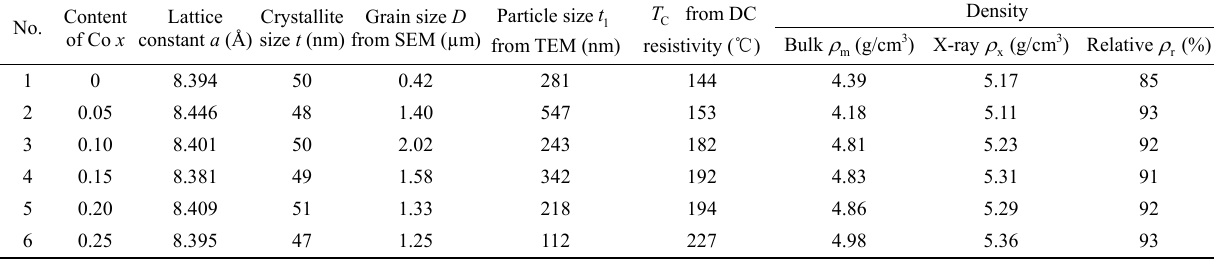
Table 1 Data on lattice constant ( a ), crystallite size ( t ), bulk density (  m ), X-ray density (  x ), relative density (  r ), grain size ( D ), particle size ( t 1 ) from TEM, Curie temperature from DC resistivity ( T C ) of Mg 0.25– x Co x Cu 0.25 Zn 0.5 Fe 2 O 4 ferrites